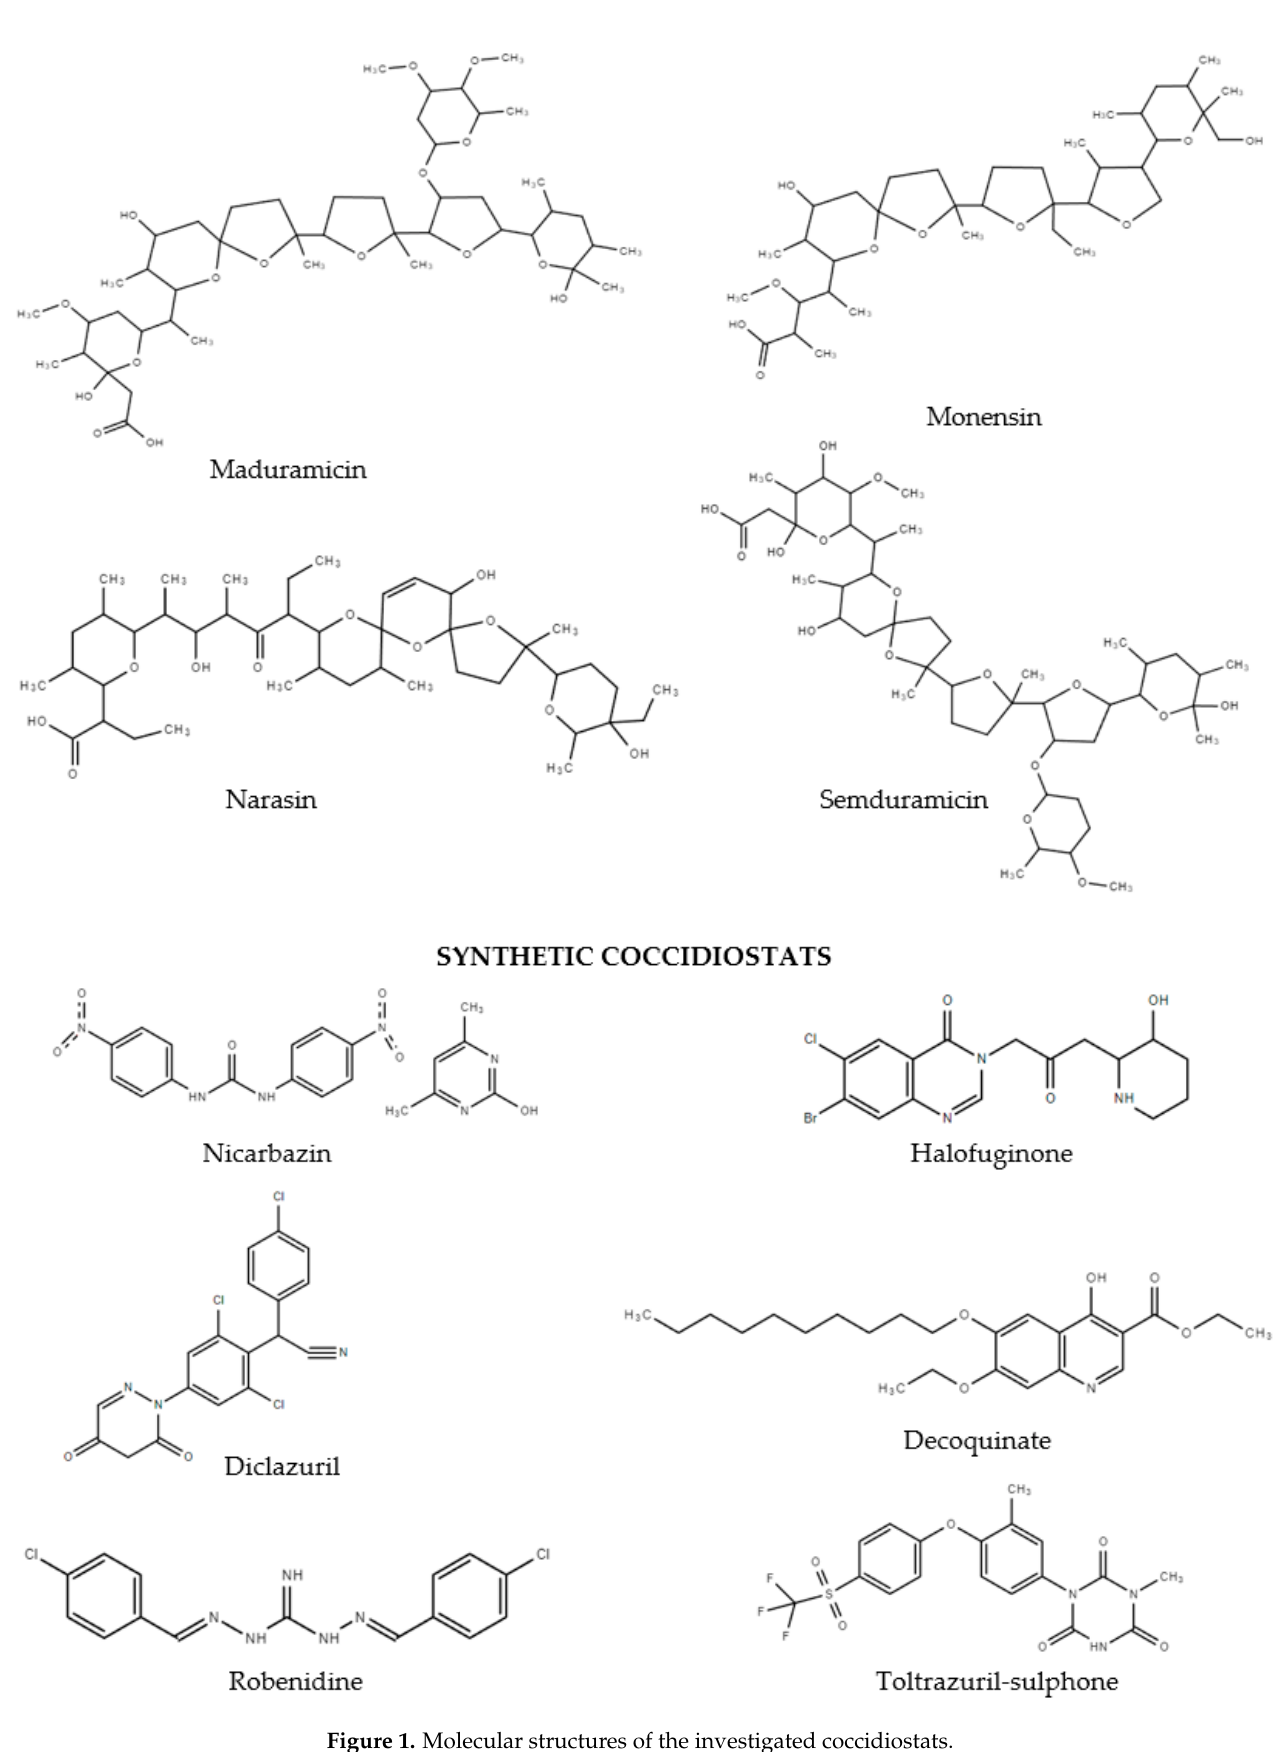
Figure 1. Molecular structures of the investigated coccidiostats.